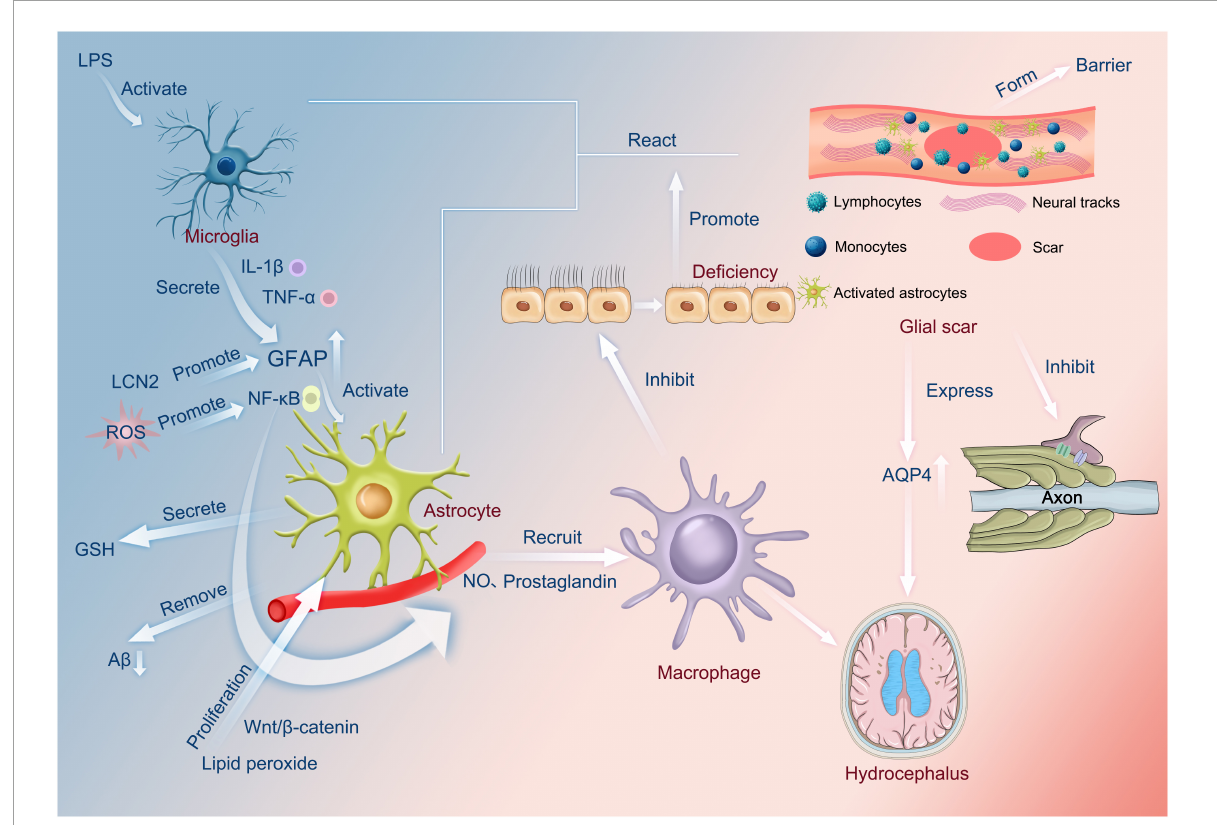
FIGURE1 Functions of astrocytes. LPS activates microglia to secrete cytokines, such as IL-1 β and TNF- α , which increase the amount of GFAP. In addition, LCN2 also promotes the increase in GFAP. The increased GFAP activates astrocytes via NF- κ B, which, in turn, recruits macrophages through the release of nitric oxide or prostaglandins. Lipid peroxide can also affect macrophages via Wnt/ β -catenin in this process, and reactive oxygen species can also influence the production of nitric oxide and prostaglandin by promoting NF- κ B and then affecting macrophages. Macrophages can inhibit normal cilia, and cilia abnormalities can occur, encouraging the interaction of microglia and astrocytes and the appearance of glial scars. On the one hand, this can produce a barrier. On the other hand, it can inhibit axonal neurotransmission and, most importantly, contribute to the overexpression of AQP4, causing hydrocephalus. In addition, astrocytes have the function of secreting glutathione and scavenging amyloid. LPS, Lipopolysaccharide; lL-1 β , Interleukin-1 β ; TNF- α , Tumor necrosis factor- α ; GFAP, glial fibrillary acidic protein; LCN2, Lipoprotein 2; ROS, Reactive oxygen species; GSH, glutathione; A β , amyloid protein; NO, nitric oxide; AQP4, aquaporin